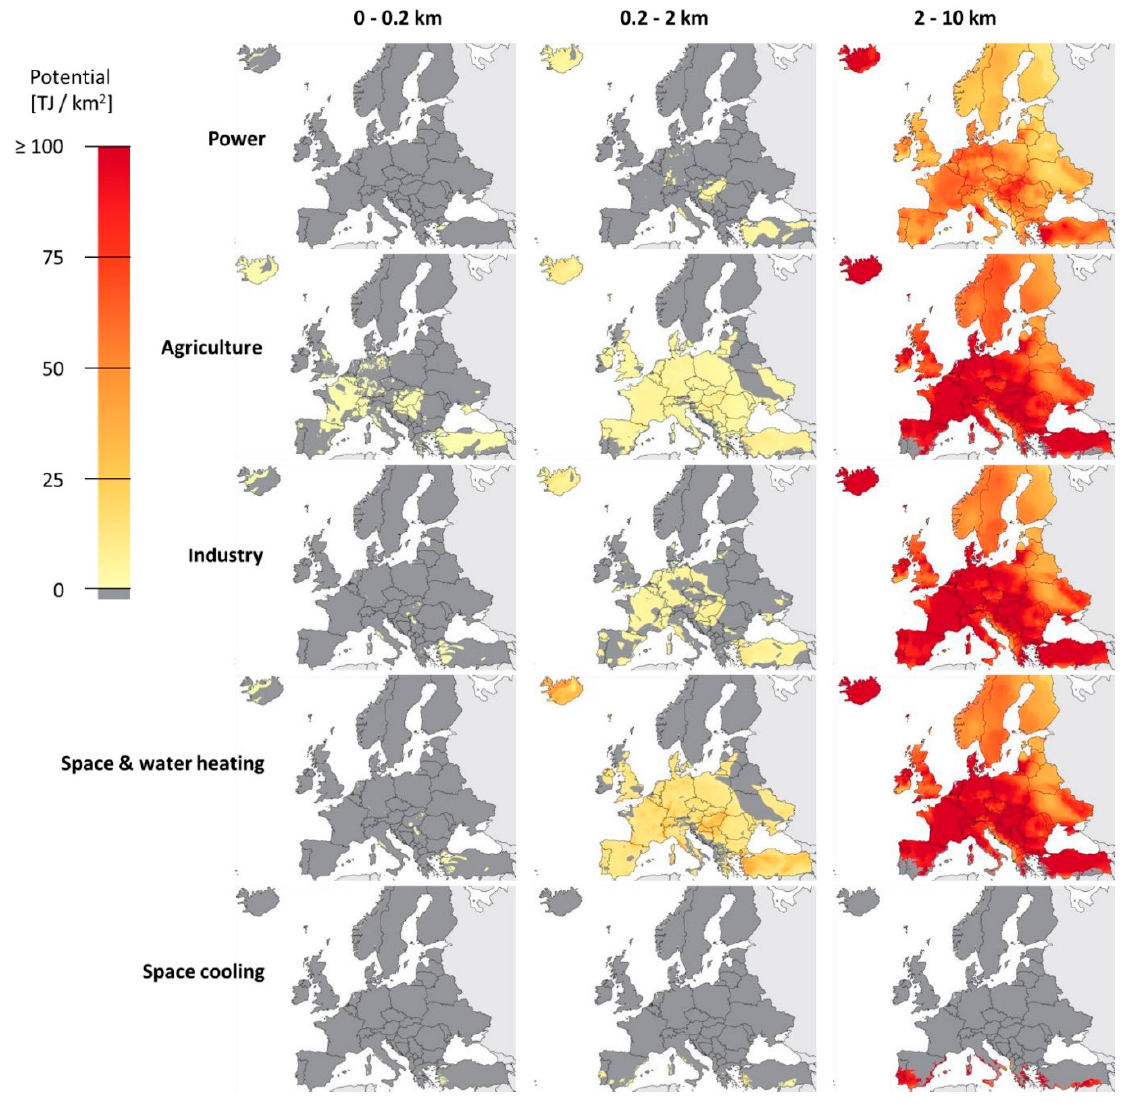
Figure 3. Long-term economic potential for various geothermal applications in Europe at three different ranges. Taken from the original source [28] (license: CC by 4.0).